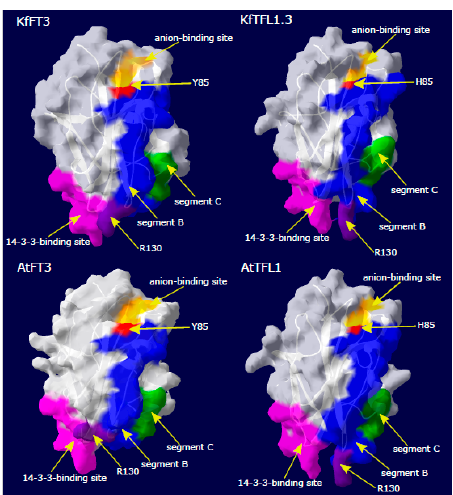
1wkpA, and TFL1 shared 69% identity with 1wkoA.